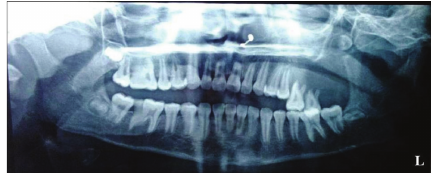
Figure 3: Orthopantomogram showing displaced molars with resorption of roots.